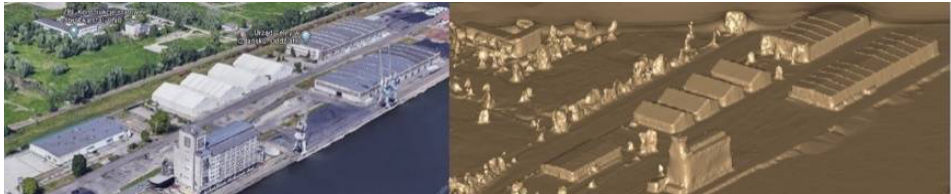
Figure 11. Numerical model of terrain coverage converted to the 3D model in Cyclone 3DR software.